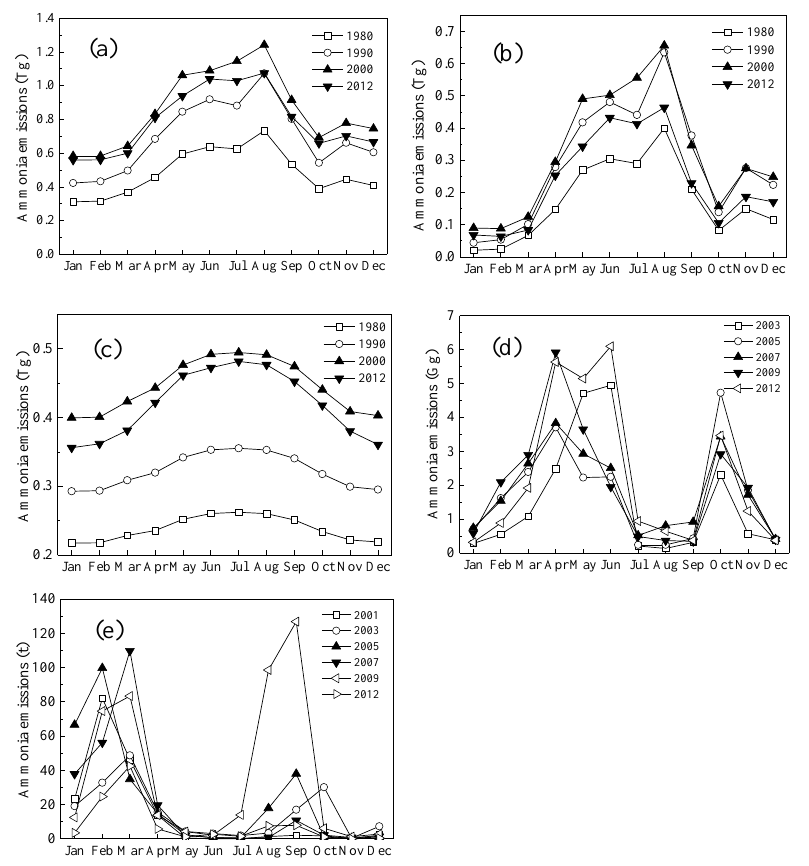
Figure 6. Monthly distribution of NH 3 emissions from different sources in China: (a) all the sources; (b) synthetic fertilizer; (c) livestock wastes; (d) crop burning in fields; (e) forest and grass